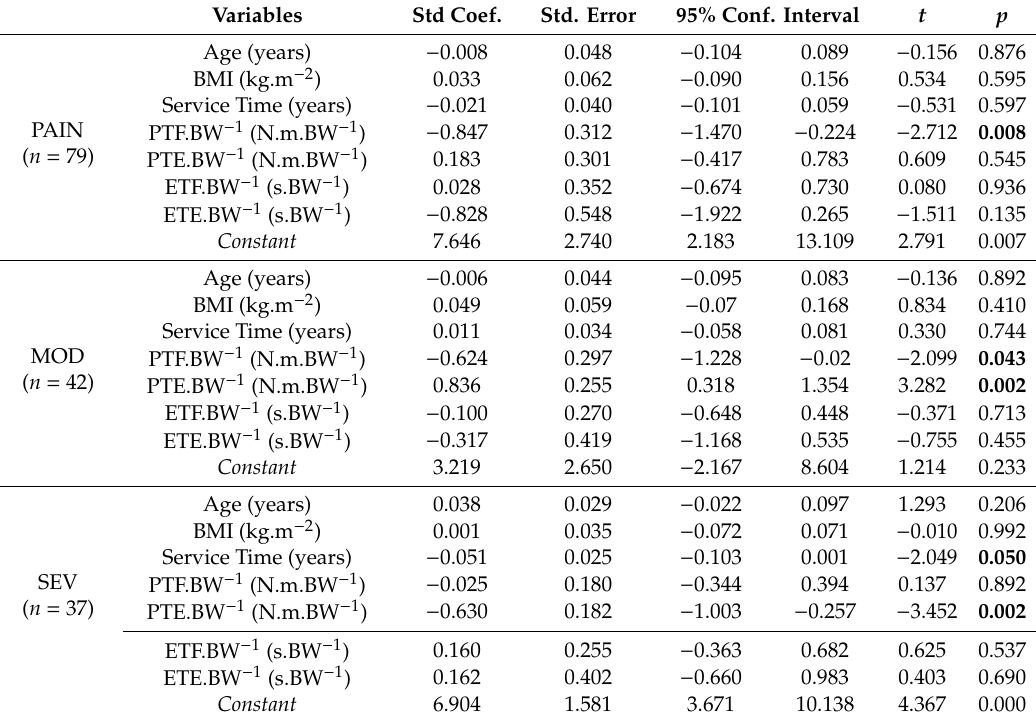
Table 2. Regression analysis with the predicting variables with moderate (MOD) and severe (SEV) pain and both groups, irrespective of pain intensity